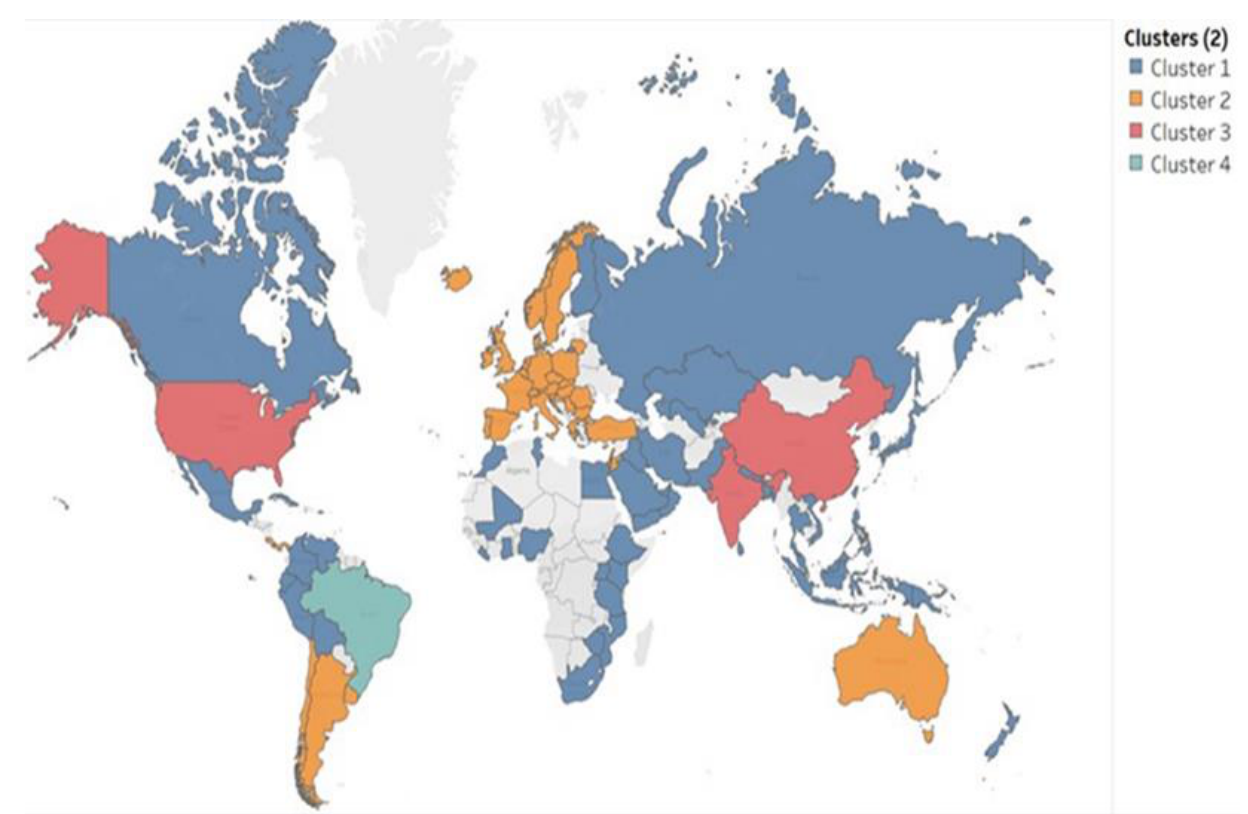
Figure 11. Cluster analysis — articles vs. COVID vs. water variables. Table 5. Cluster analysis diagnostics and features — articles vs. COVID.